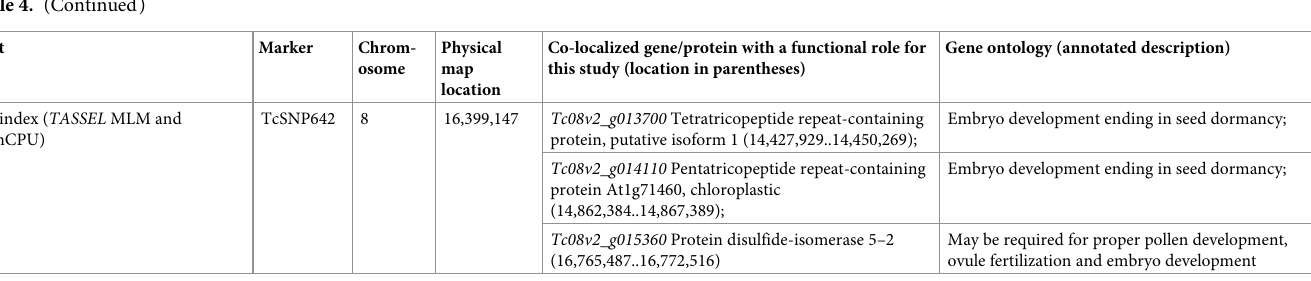
Physical Co-localized gene/protein with a functional role for map this study (location in location